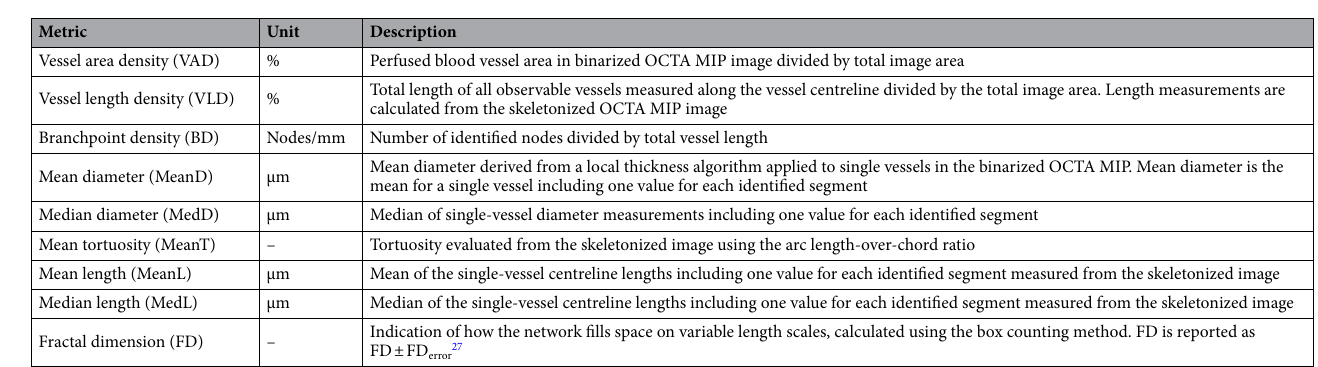
Table 1. A summary of the metrics evaluated in this study. All metrics were calculated using the open-source software OCTAVA 26 .